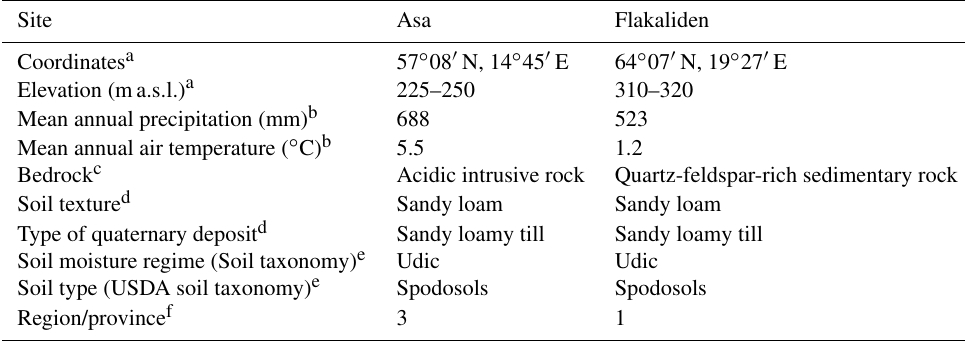
Table 1. Characteristics of the study